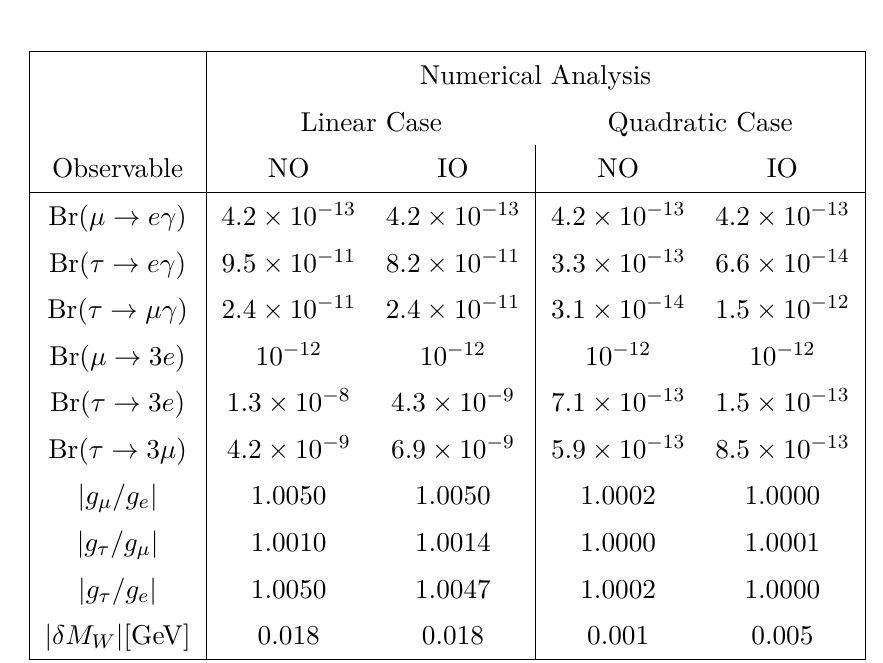
Figure 8 . Plot of the coupling ratios | y eµ The colours are the same as in figure 2.